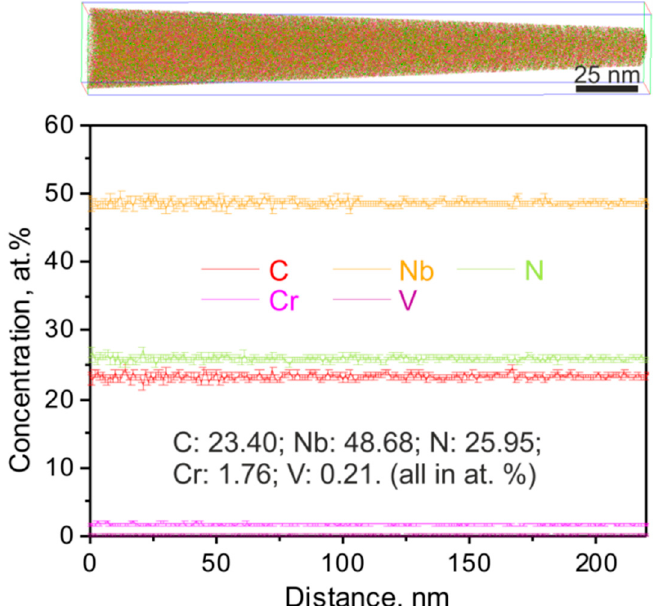
Figure 7. Three-dimensional reconstruction and one-dimensional compositional profiles of all elements in a representative APT tip taken from a carbonitride in the long-term aged Super304H steel.